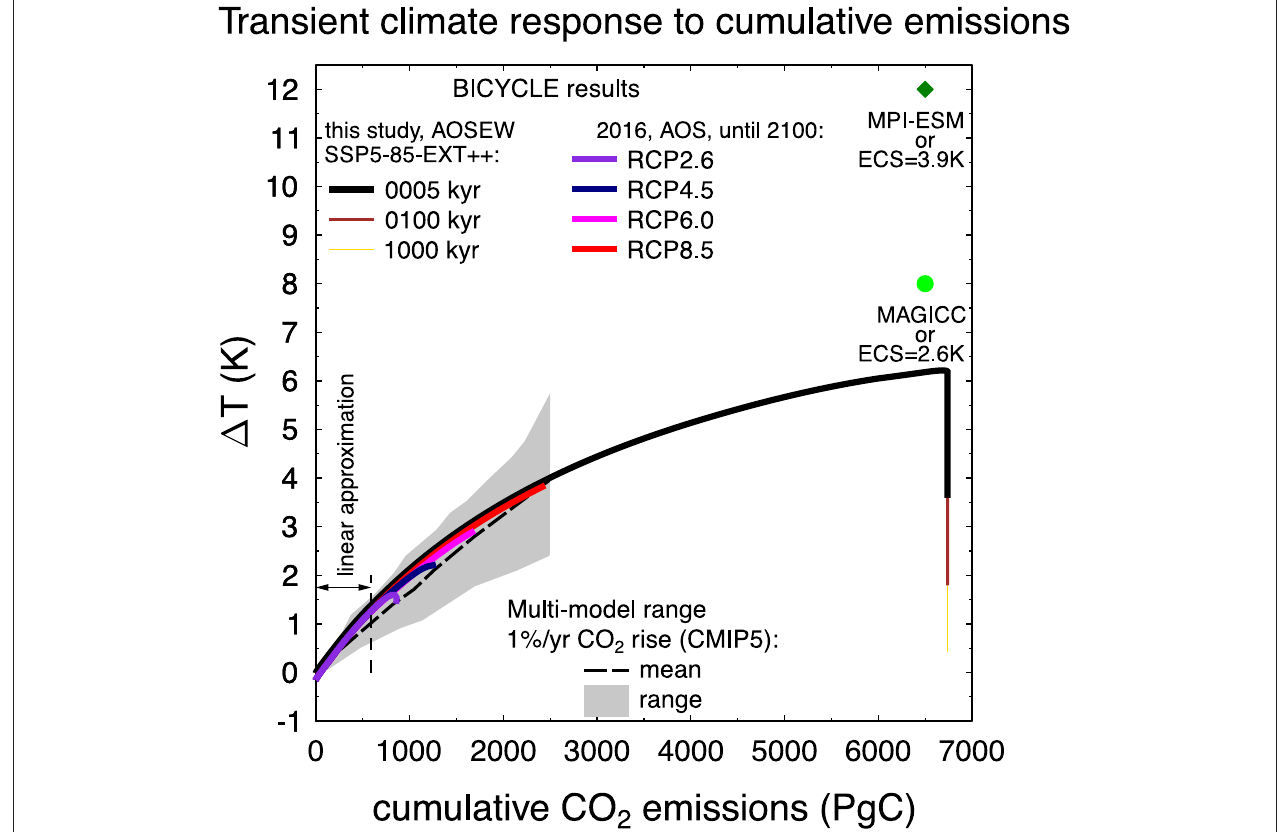
FIGURE 7 | Global mean surface temperature increase as a function of cumulative net global CO 2 emissions, known as transient climate response to cumulative emissions (TCRE) for results from BICYCLE and other models. From this study, results for CTRL (emissions following scenario SSP5-85-EXT++) in model version AOSEW for 5, 100, and 1,000 kyr are shown. In addition, four different RCP emission scenarios (BICYCLE, model version AOS) from Köhler (2016) are included. The 2016 results show changes from the beginning of the emissions (year 1765) until year 2100. For the BICYCLE results I directly calculate 1 T from CO 2 using a transient climate response of 2 K as given in the methods. For comparison the multi-model mean and range simulated by CMIP5 models, forced by a CO 2 increase of 1% per year is given by the broken black line and gray area (after Figure SPM 10 of IPCC, 2013). These simulations exhibit lower warming than those driven by RCPs within CMIP5, which include additional non-CO 2 forcing and therefore lead to higher temperature changes. For the CMIP5 results, 1 T until the year 2100 is calculated relative to the 1861–1880, and CO 2 emissions relative to 1870. I also included the discussed warmings obtained with an ECS of 2.6 or 3.9 K, identical to the simulations for SSP5-85-EXT CO 2 emissions (6500 PgC) obtained with the simple climate model MAGICC (O’Neill et al., 2016) and MPI-ESM (Kleinen, personal communication). The range with cumulative emissions < 590 PgC approximated by a linear relationship in the TCRE in the analysis is also